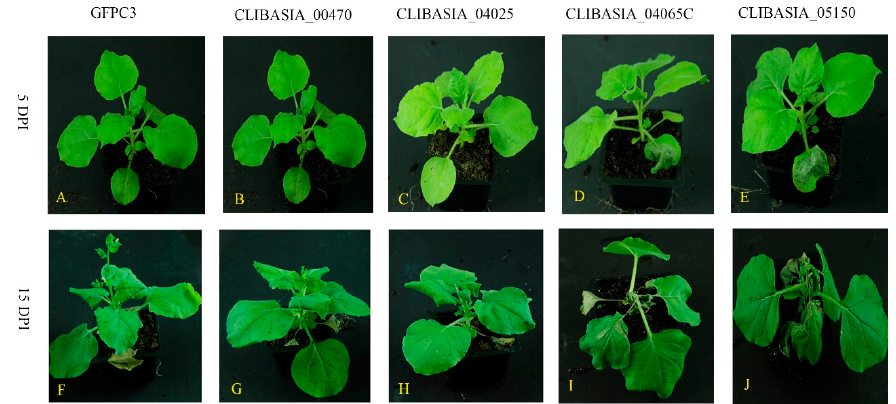
Figure 1. N. benthamiana expression four putative virulence factors showed strong phenotypes. By expression the total 60 selected putative virulence factors via TMV in N. benthamiana , four